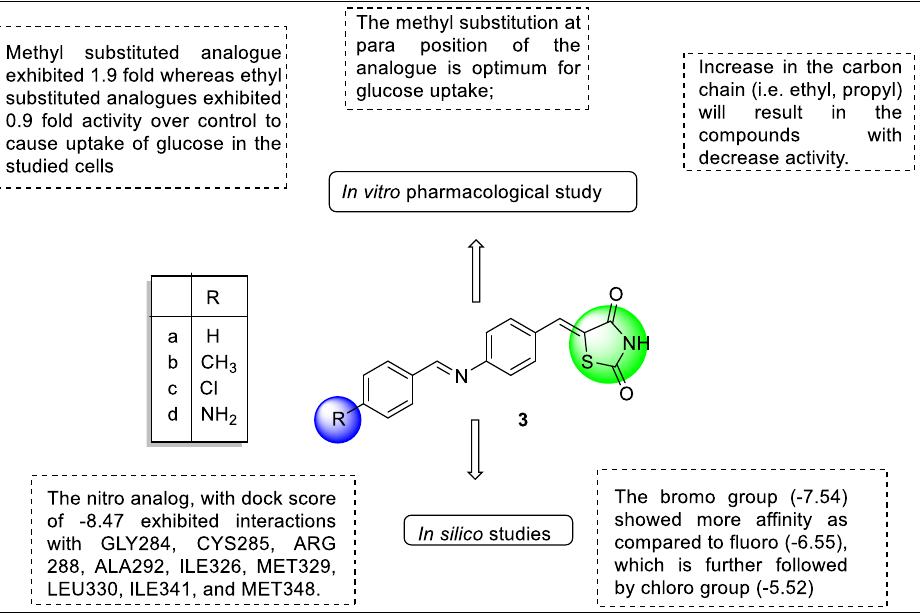
( 6 ) (4-thiazolidinedione derivatives) along with rosiglitazone, and pioglitazone were tested for their involvement in PPARs receptors in the mechanism of pro-apoptotic action and their cytotoxicity using the squamous carcinoma (SCC-15) cell line. The PPARα , P PARβ, and PPARγ mRNA expression were examined using 4 -thiazolidinone com- pounds and PPAR-specific siRNA. Cell survival, cell metabolism, and caspase-3 activity were also assessed after PPARα , PPARβ, and PPARγ siRNA gene suppression. The mRNA expression of PPARs decreased in SCC-15 cells treated with Les-2194, Les-3377, and Les-3640. The cytotoxic effect of the examined drugs (50 µM) was prevented by PPARγ knockdown. In SCC -15 cells, it was found that the new anticancer 4-thiazolidinone compounds act mostly v ia the PPARγ pathway ( Figure 9). The authors found that all the compounds emerged as PPARγ modulators. Silencing the PPARγ gene raises the PPARα and PPARγ mRNA F in SCC -15 cells, which is interesting. The anticancer activity of the newly discovered chemicals was better than that of rosiglitazone and pioglitazone [130].